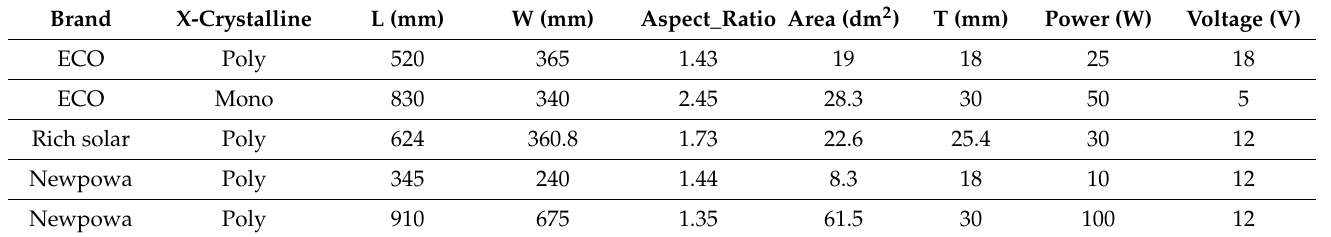
Table A1. Details of the solar panels used in the experiments. X-crystalline (cell composition): Polycrystalline or Monocrystalline, which have slightly different colors. L: Length. W: Width. T: